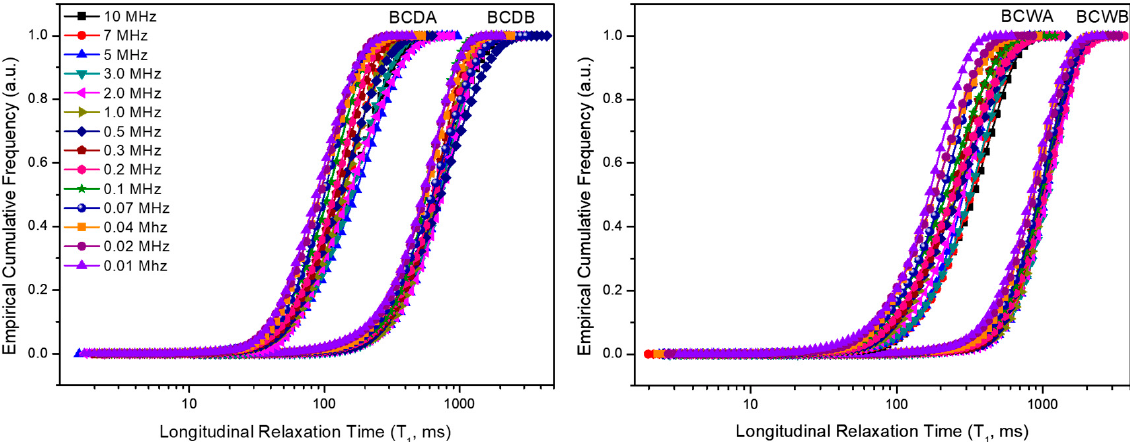
Figure 1. The empirical cumulative frequency distribution curves at all the proton Larmor frequencies used in this study are plotted versus the longitudinal relaxation time ( T 1 ). BCDB, BCDA, BCWB, and BCWA stand for biochar (BC) dry—(D), and wet—(W) quenched, before (B), and after (A) application to soil.